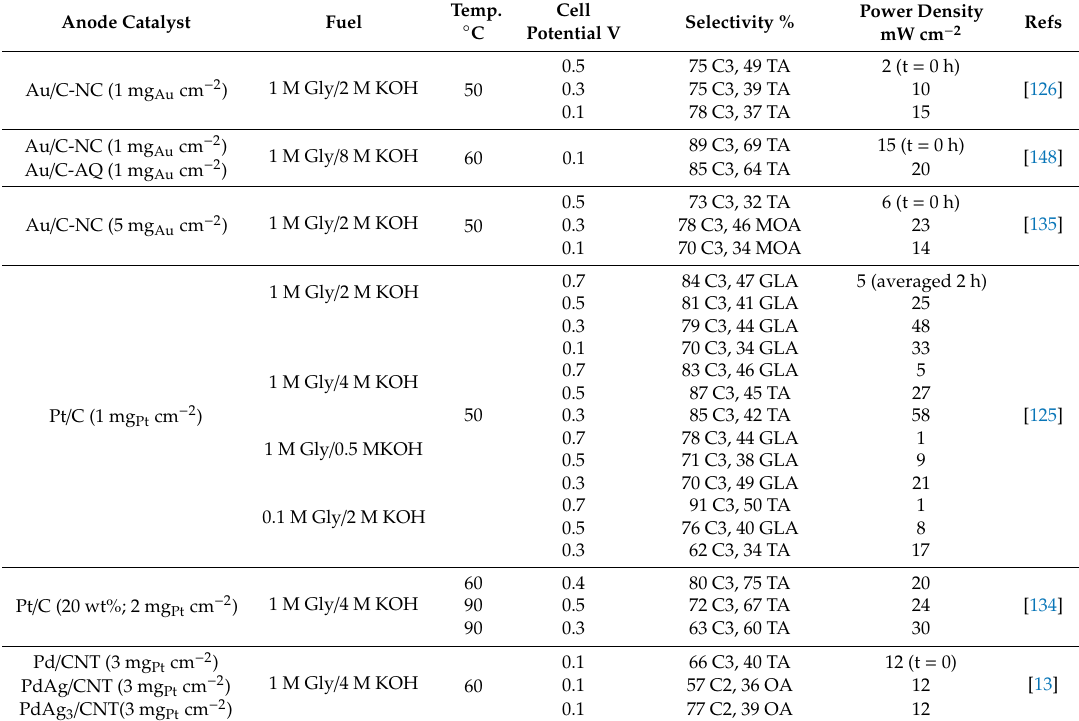
Table 5. Selectivity, in terms of total C3 (C2) content and of the compound present in the highest concentration, and power density of some ADGFC for value-added chemical and energy production. Anode Catalyst Fuel